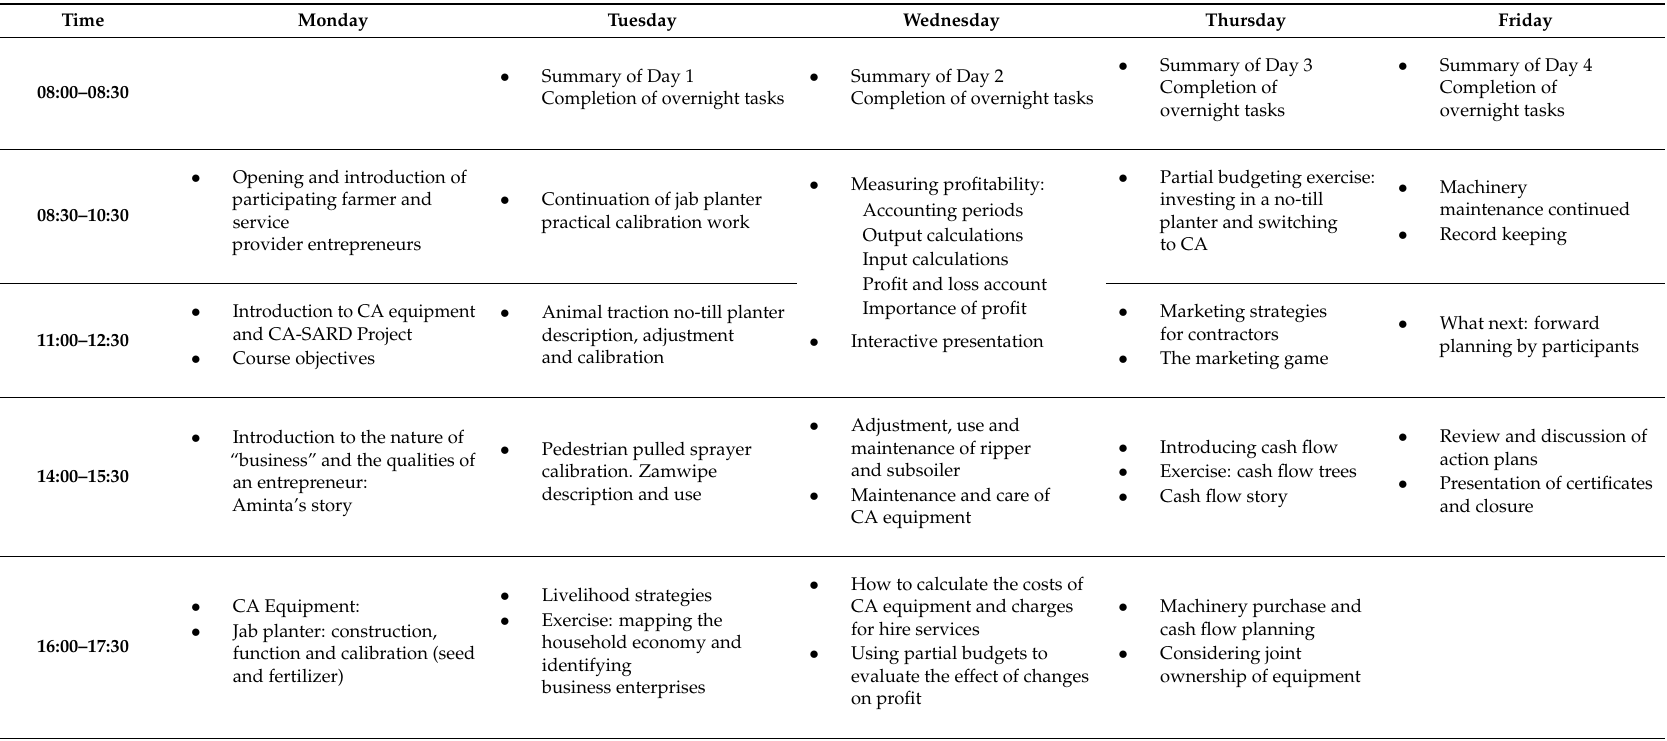
Table A1. Conservation agriculture (CA) equipment and entrepreneurship training: Karatu,